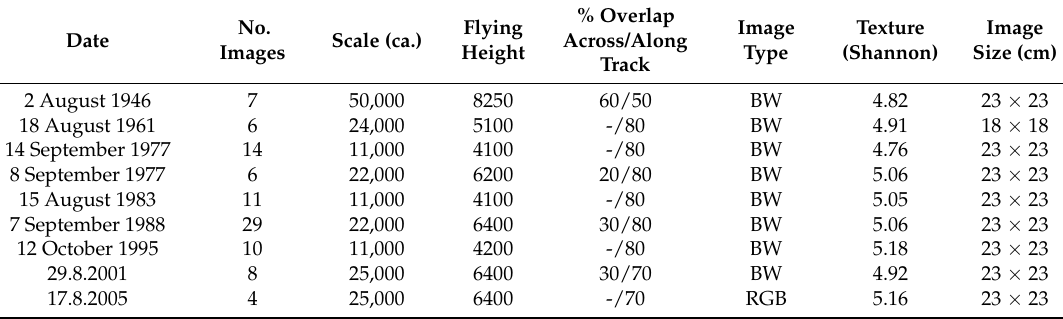
Table 1. Aerial imagery input data. The Shannon entropy is a measure of image texture